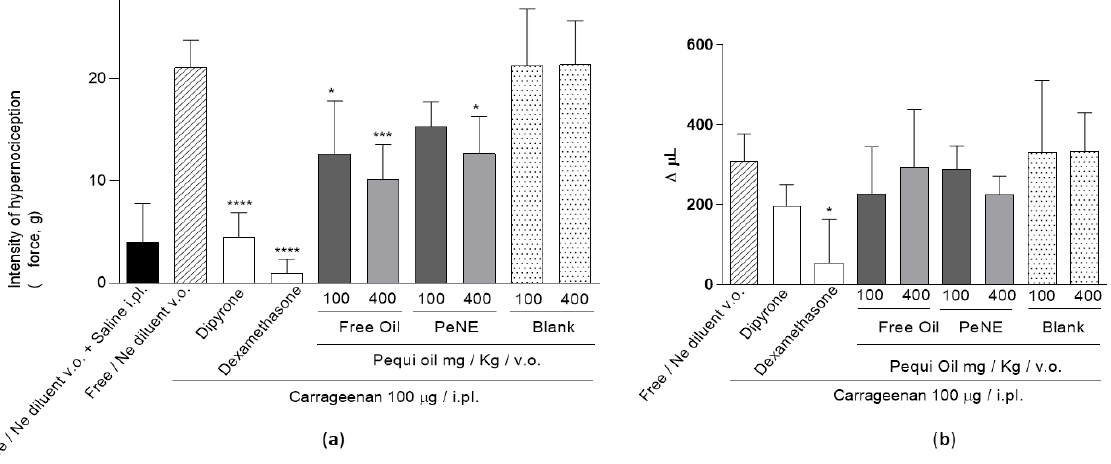
Figure 6. Carrageenan-induced hypernociception in rats is inhibited by the free or nanoencapsulated pequi oil. The figure shows the hypernociception ( a ) or edema ( b ) induced by a single i.pl. injec- tion of carrageenan (100 g/paw) and the effect of pre-treatment with free/Ne diluent or dipyrone (120 mg/kg/i.p.) or dexamethasone (2 mg/kg/i.p.) or free oil (100 and 400 mg/kg/p.o.) or nanoen- capsulated pequi oil (PeNE 100 and 400 mg/kg/p.o.) or the blank. PeNE, free pequi oil, and the blank were administered daily for 15 days prior to carrageenan injection. The data are expressed as mean ± SEM; ( n = 4–7). One-way ANOVA with Tukey’s comparison: significant difference compared to the oil/Ne diluent plus carrageenan group *** p < 0.001, **** p < 0.0001 ( a ) and * p < 0.05 ( b ). Besides showing an antinociceptive effect, the treatment with PeNE or free pequi oil (same doses) did not show an effect against the carrageenan-induced edema (Figure 6b). As expected, dipyrone did not show an anti-inflammatory effect and dexamethasone inhibited the edema by 82% ( p < 0.05). The antinociceptive effect observed by oral treatments with PeNE or free pequi oil is not due to motor coordination impairment since no significant difference was observed among treatments (Figure